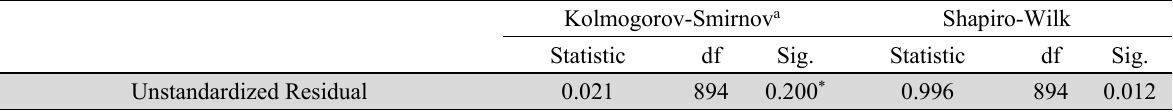
Kolmogorov-Smirnov a Shapiro-Wilk Statistic Sig.